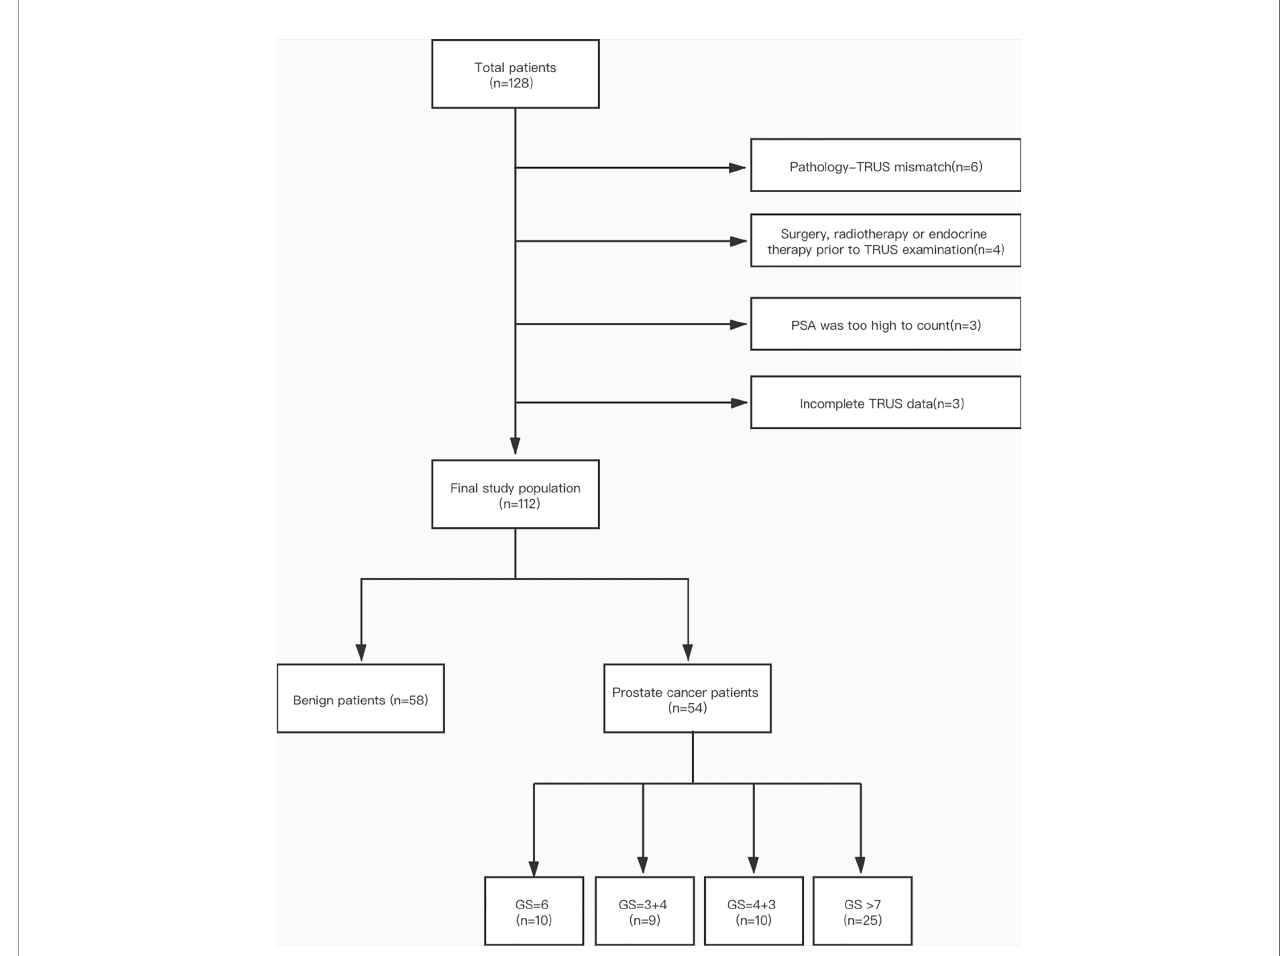
FIGURE 1 | Patient selection fl ow